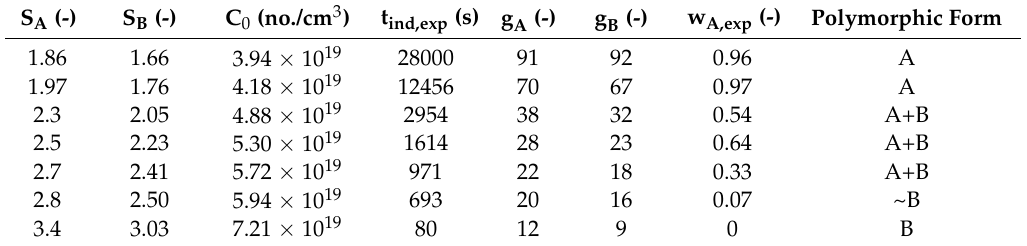
Table 2. The experimental induction time data and the final measured weight fractions of eflucimibe polymorphs for various supersaturation at 35 ◦ C reported by Teychene and Biscans